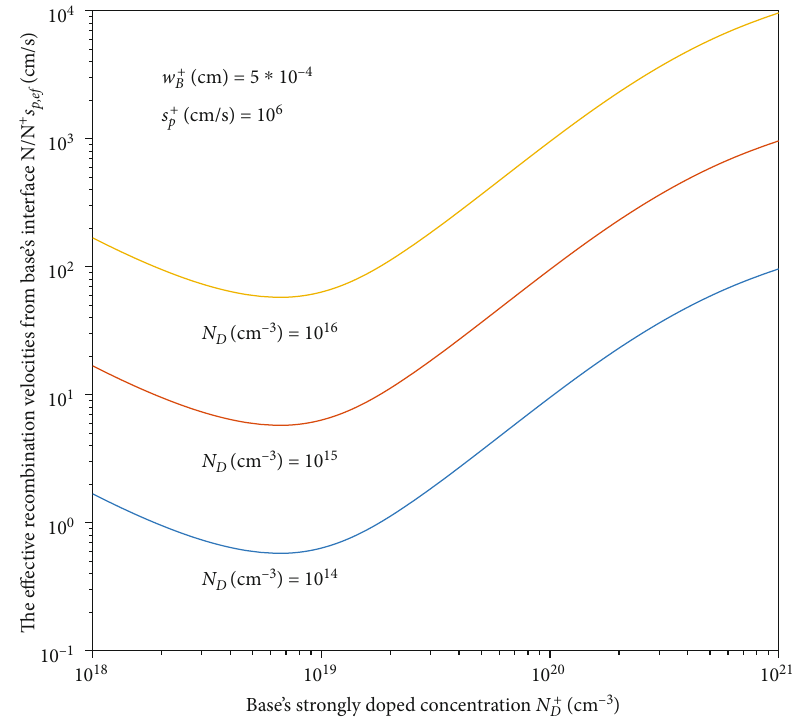
’ s strongly doped concentration N p , ef dependent on base D + in